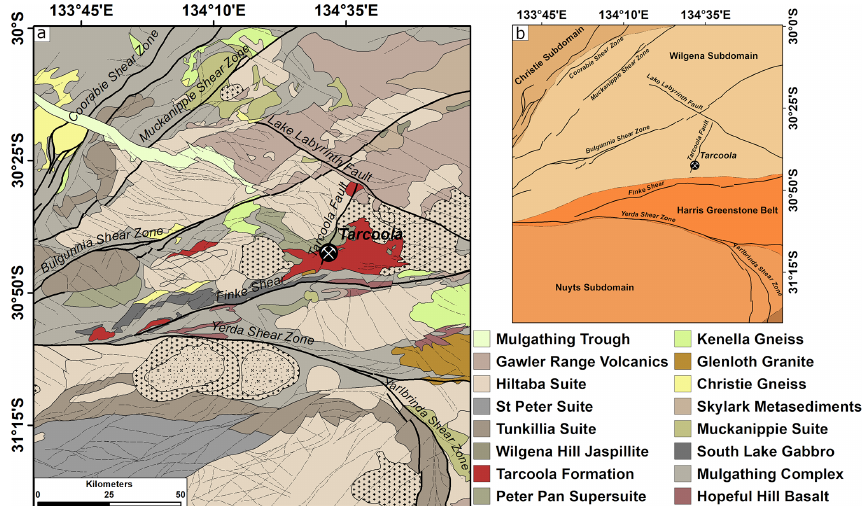
Figure 2. (a) Structural interpretation of the subsurface based on magnetic, outcrops, and drill hole data (Pawley and Wilson, 2019). Large mylonitic shear zones cross the area dominantly in a SW–NE direction. Strong influence on feature extraction is expected from plutonic bodies and mylonite zones. Coorabie Shear Zone: CoSZ, Muckanippie Shear Zone: MuSZ, Lake Labyrinth Fault: LaLF, Yerda Shear Zone: YeSZ, Yarlbrinda Shear Zone: YaSZ, Finke Shear: FiS, Bulgunnia Shear Zone: BuSZ, Tarcoola Fault: TaF. (b) Structural domains of the study area. The boundaries of the domains often coincide with crustal-scale shear zones. The location within the Gawler Craton of the area shown in this figure is indicated in Fig. 1.